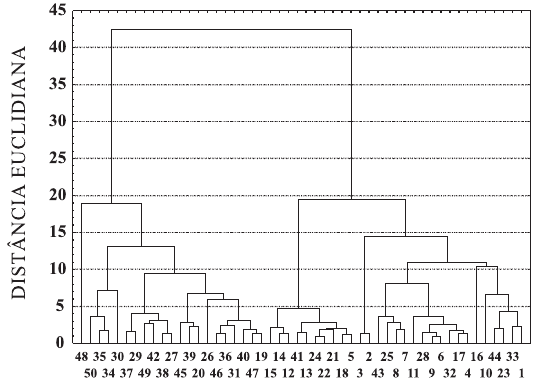
Figura 4. Dendrograma ilustrativo resultante da análise de agrupamento dos nove primeiros componentes principais.